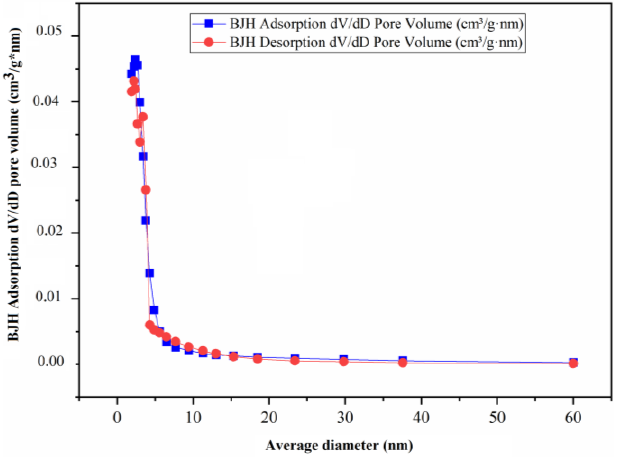
Figure 6. BJH Adsorption and desorption dV/dD pore volume of catalyst - 2.